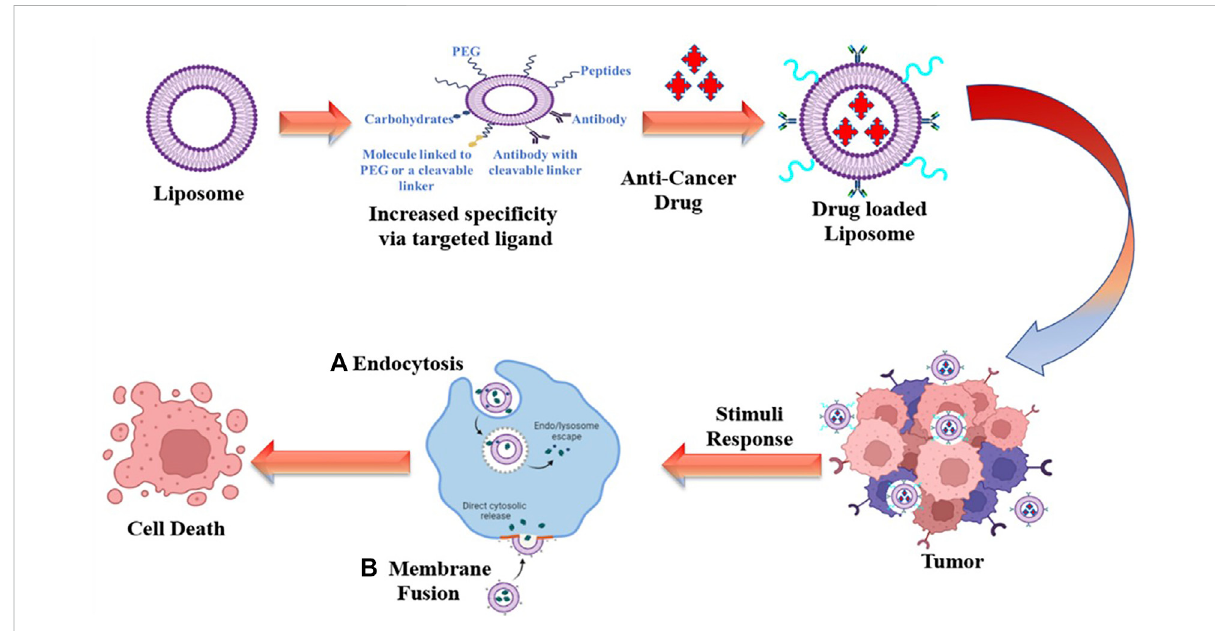
FIGURE 1 Overview of a SDDSs using liposomes as smart